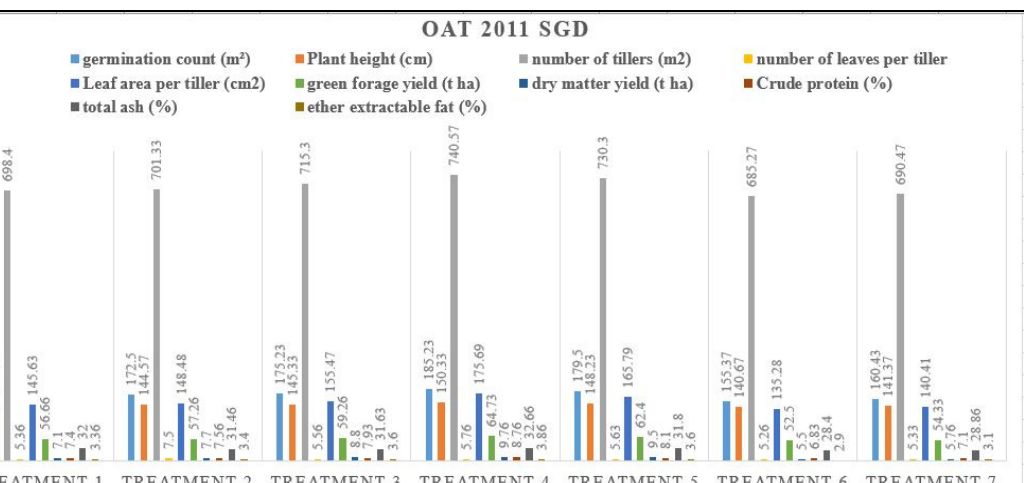
Figure 3. Effect of (INM) on oat cultivar Sargodha 2011 .